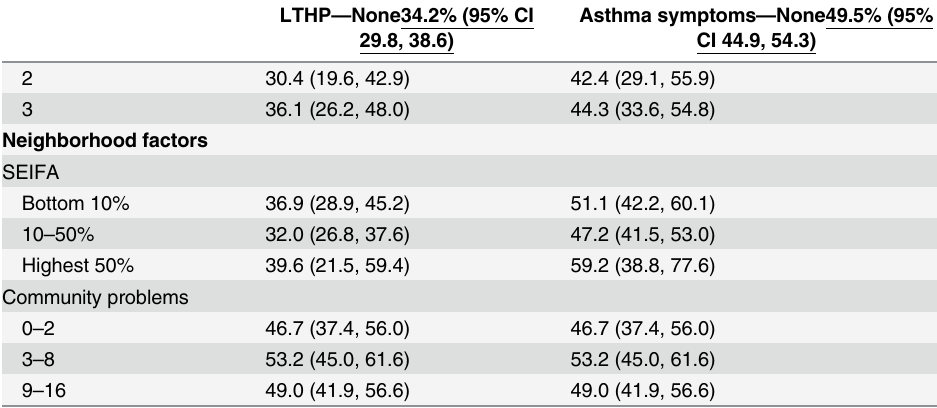
most disadvantaged.